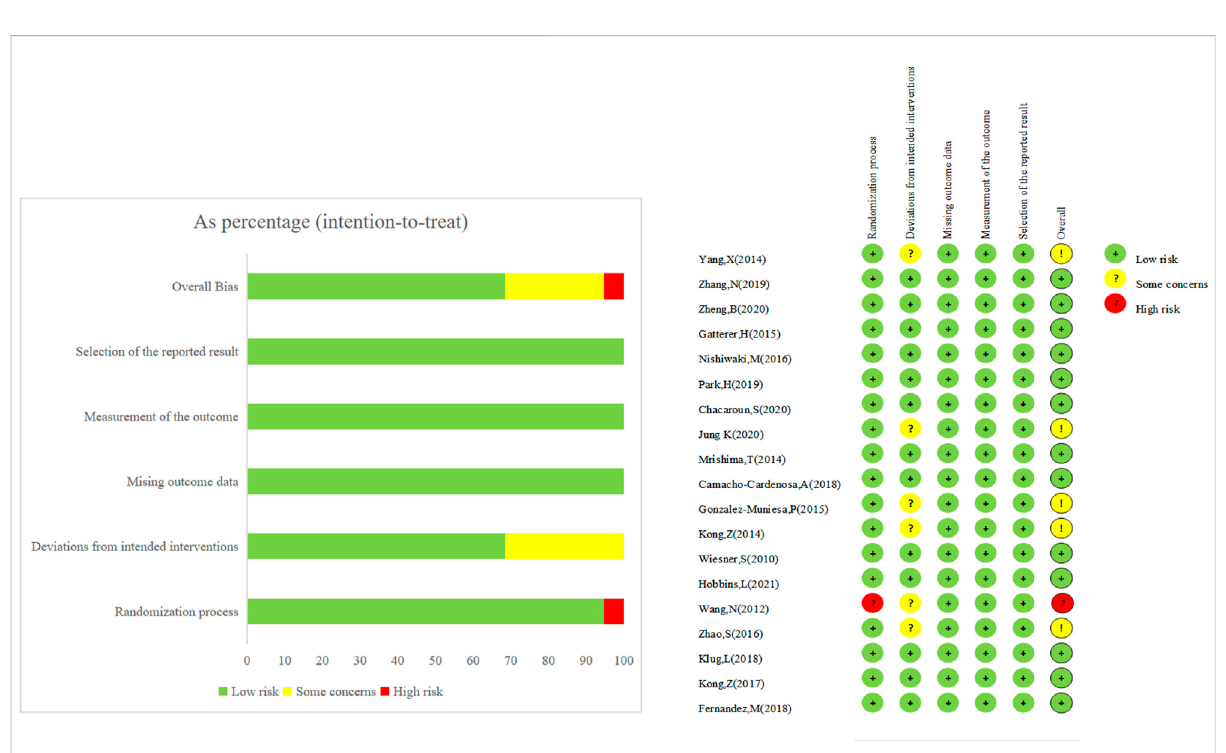
FIGURE 2 The risk assessment of